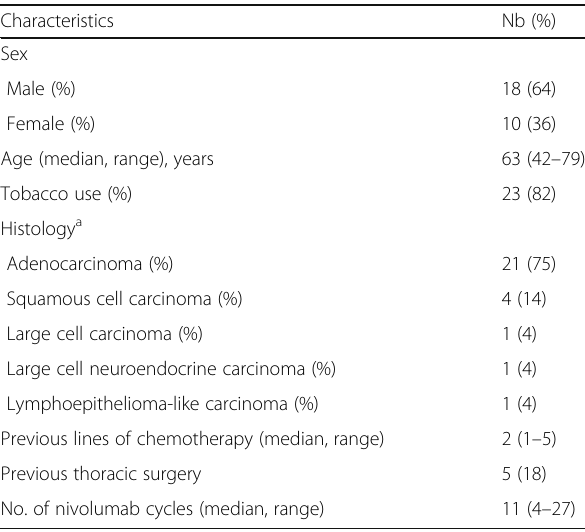
Table 2 Patient characteristics ( n = 28) Characteristics